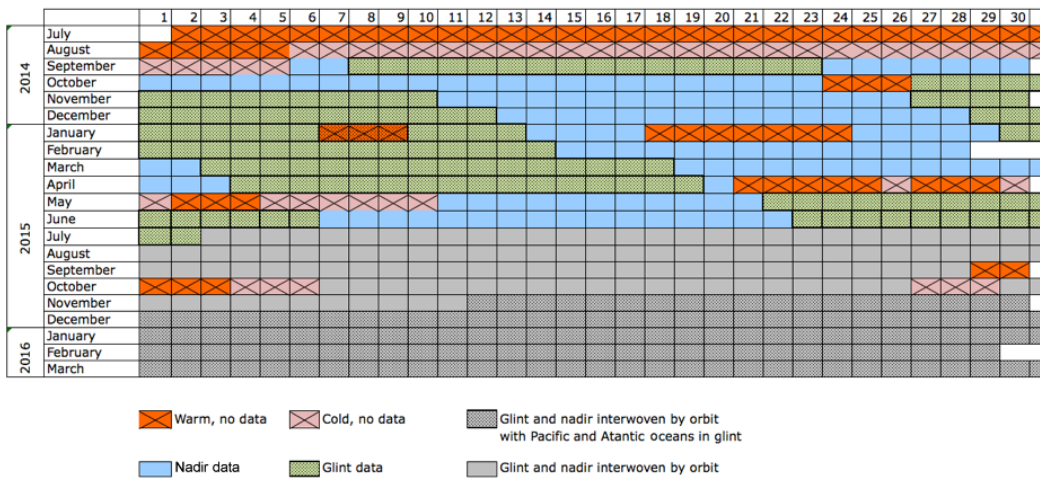
Figure 1. OCO-2 data calendar with observation modes and data outages.